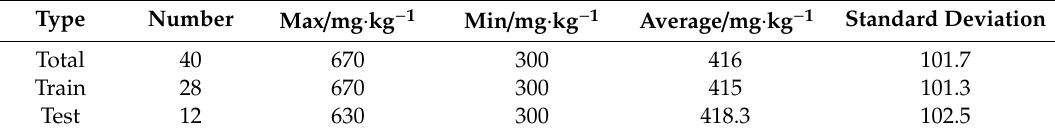
Table 8. High concentration of soil-available potassium sample statistics.